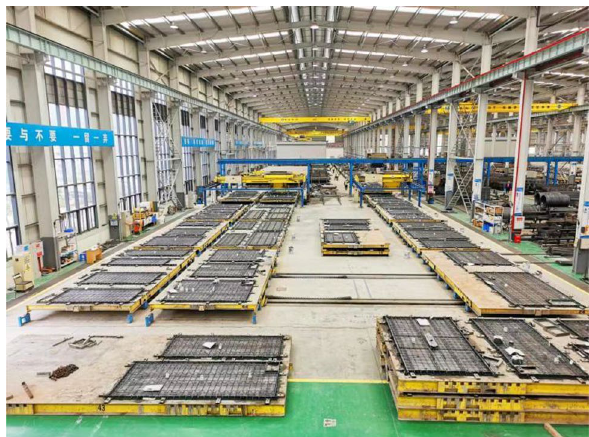
Figure 1. Intelligent manufacturing site.